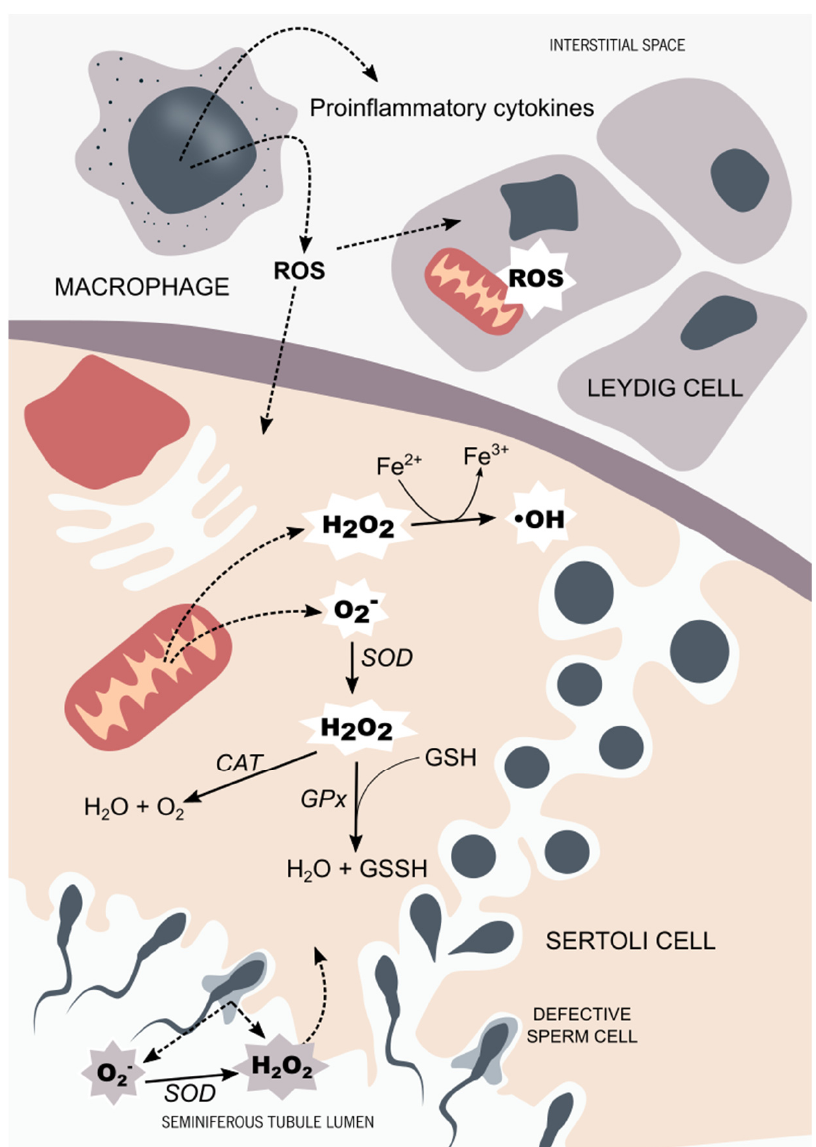
Figure 1. Testicular tissue oxidant/antioxidant balance. In the testicular tissue, the main sources of reactive species are activated in testicular macrophages and defective germ cells. The hydroxyl radicals (OH) and the superoxide anion (O 2 − ), along with the hydrogen peroxide (H 2 O 2 ), are the ROS that more often target the male reproductive system. Sertoli cells and Leydig cells are equipped with a very efficient antioxidant system. The main antioxidant enzymes found in the male reproductive system are superoxide dismutase (SOD), catalase (CAT), and glutathione peroxidase (GPx), along with non-enzymatic antioxidants, such as glutathione (GSH). Testicular cells are very sensitive to OS. Thus, a prolonged OS situation affects the steroidogenesis capacity of Leydig cells through mitochondrial impairment. Developing germ cells are also susceptible to OS, which is thought to be part of the complex signaling pathway responsible for selective germ-cell death. In order to maintain the homeostasis of seminiferous tubules, the oxidant, and antioxidant species balance each other, maintaining an adequate environment for steroidogenesis and spermatogenesis to occur.